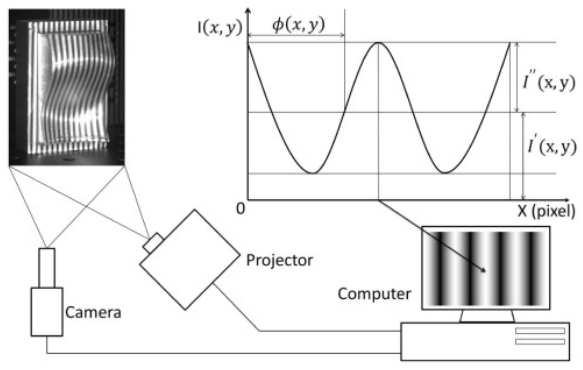
Figure 10. Fringe projection (Lin et al.,